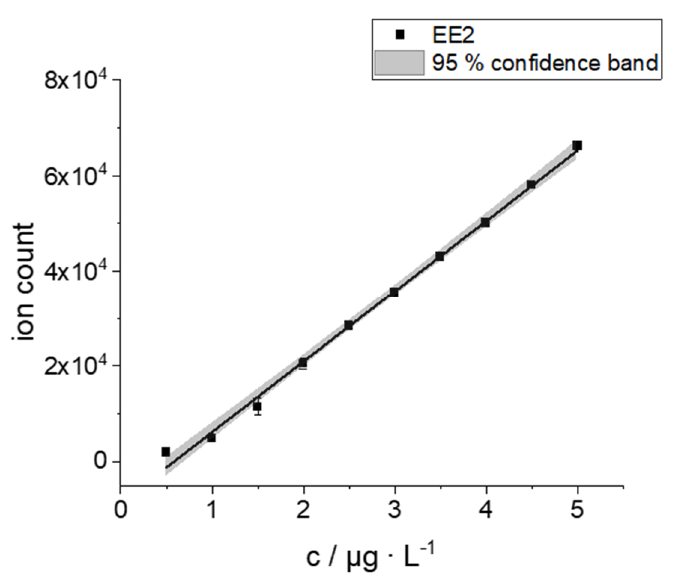
Figure 1. Calibration curve formed by GC ‐ MS measurements of nine calibration standards ranging from c = 5 mg L − 1 to c = 45 mg L − 1 with an increment of ∆ c = 5 mg L − 1 ; quintuple determination; linear regression, slope: 199,271.79 L mg − 1 ± 5,681.07 L mg − 1 , point of intersection with the ordinate: − 481,783.45 ± 159,845.77, R 2 = 0.997; ion counts determined by the integration of the EE2 signal in the obtained EIC chromatograms (EIC = extracted ‐ ion current; precursor ions: 440 m/z, 425 m/z); concentration values represent the EE2 concentration in aqueous solution during the catalytic experiments.